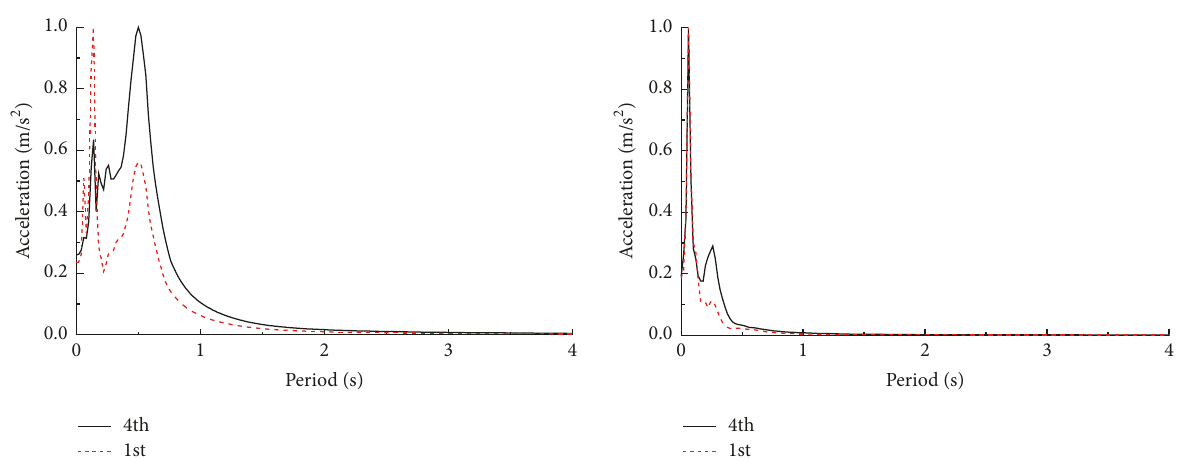
Figure 10: Horizontal and vertical acceleration response spectrum curves of the fourth and first floor under standard case (HV).